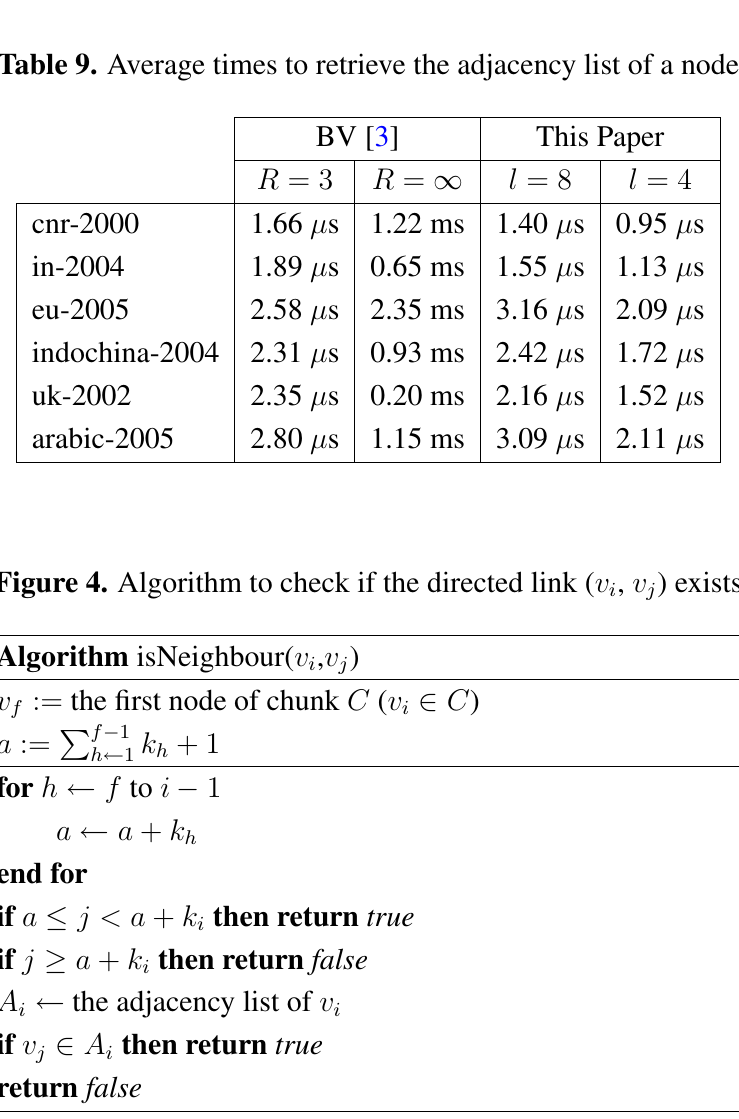
Table 9. Average times to retrieve the adjacency list of a node.